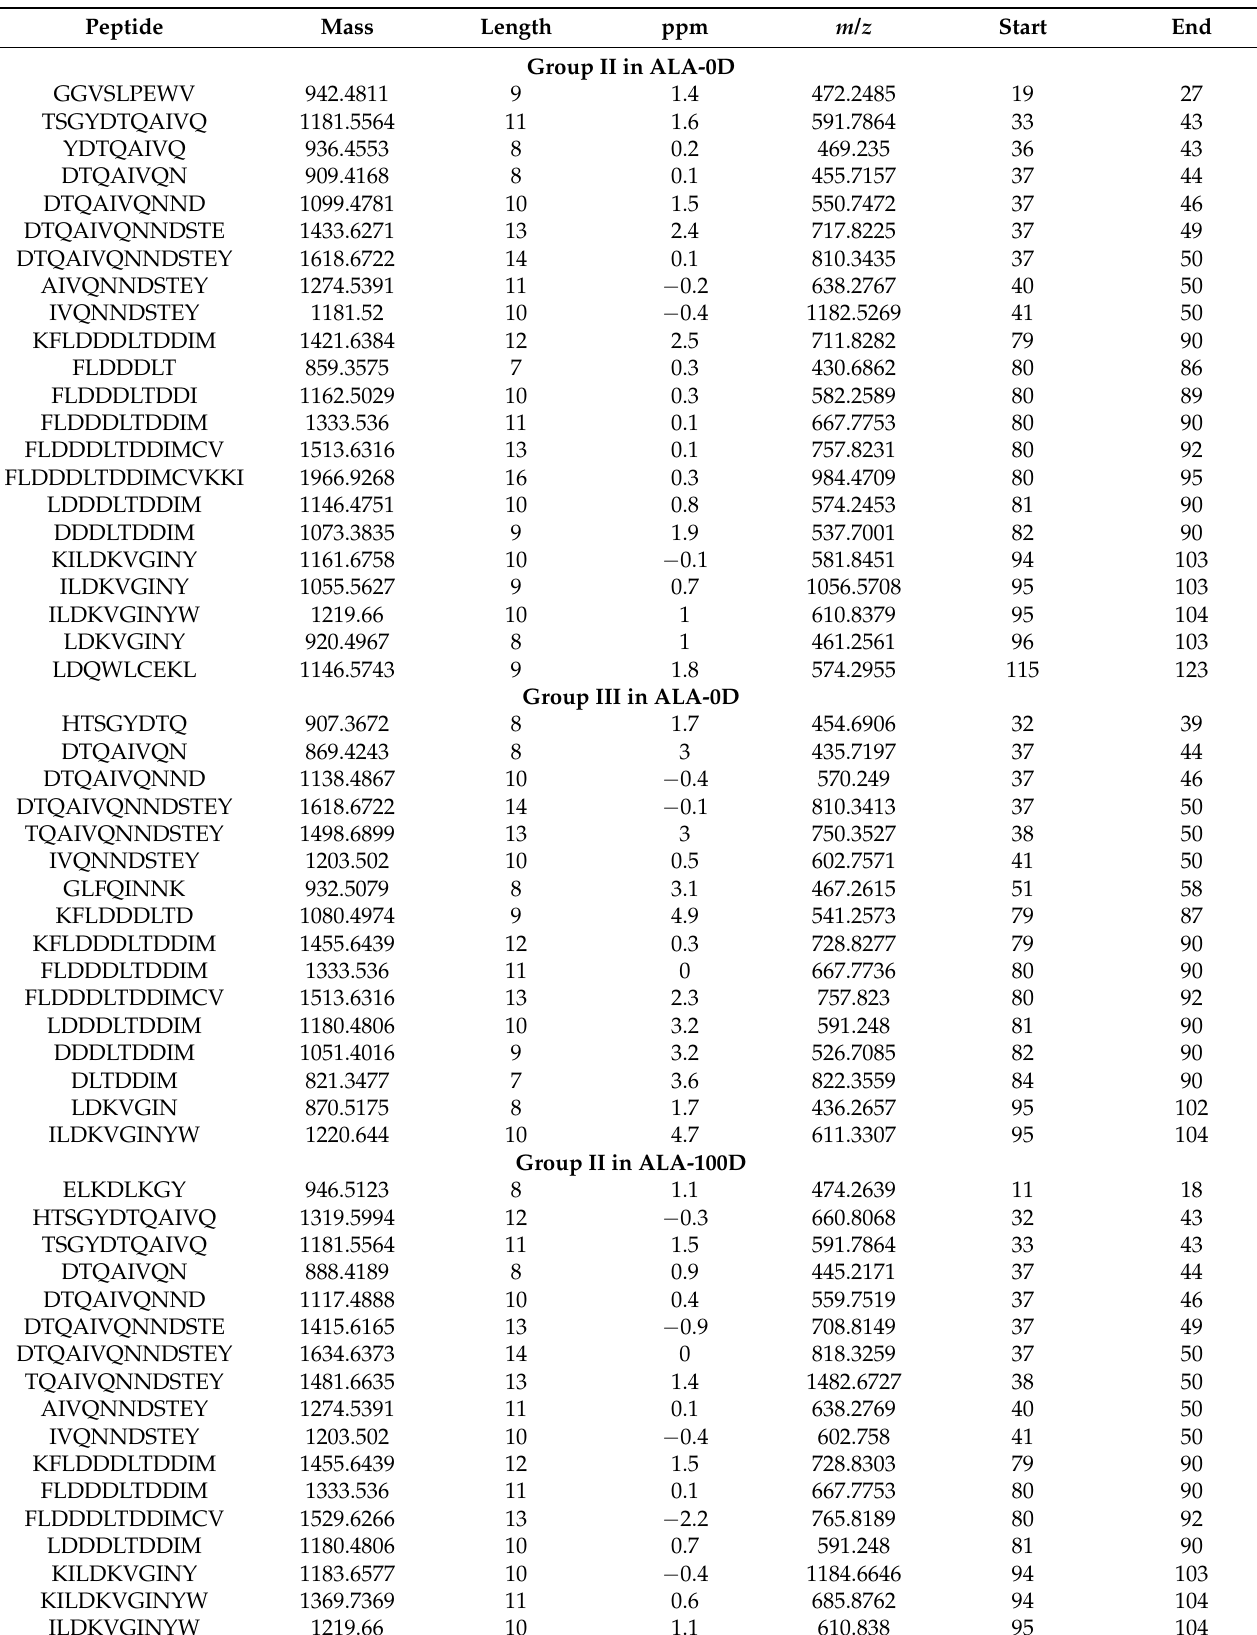
Table 1. The anti-digestive stable peptides determined by high-performance liquid chromatography system coupled to tandem mass spectrometry